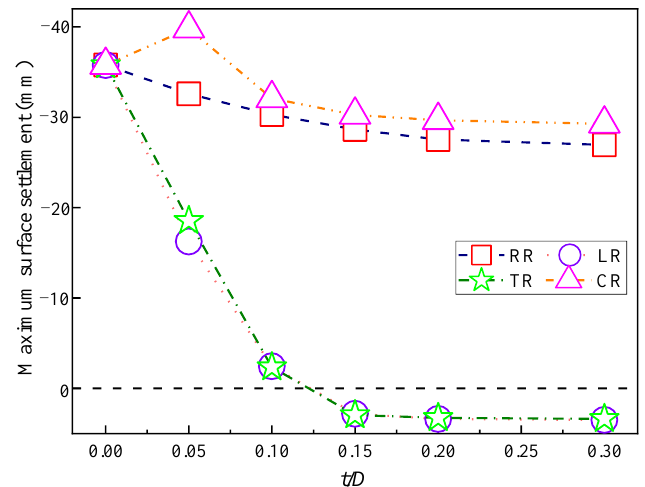
Figure 6. Variation of the maximum surface settlement with t.